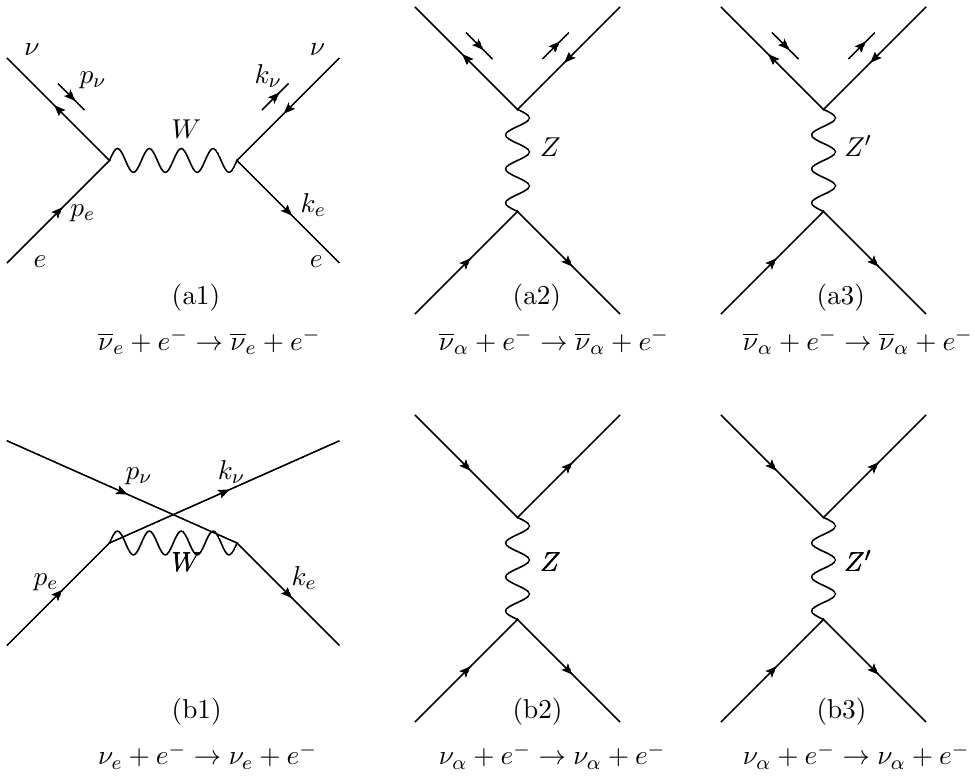
Figure 5 . The Feynman diagrams of (cid:23) (cid:11) + e (cid:0) ! (cid:23) (cid:11) + e (cid:0) (upper three diagrams) and (cid:23) (cid:11) + e (cid:0) ! (cid:23) (cid:11) + e (cid:0) (lower three diagrams). The W -mediated diagrams (a1) and (b1) exist only when (cid:11) = e